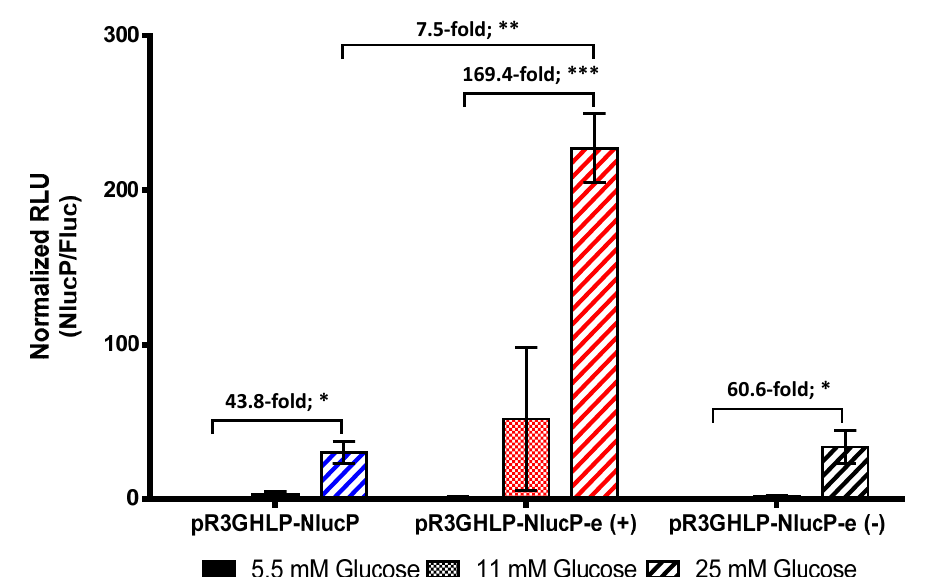
Figure 5. Incorporation of human albumin 3 (cid:48) untranslated region with intron, 3 (cid:48) albumin enhancer (3 (cid:48) iALB) for improved glucose responsiveness and enhanced gene expression level. Glucose responsive gene expression conferred by pR3GHLP-NlucP-e (3 (cid:48) iALB denoted as “e” in plasmid’s name) at various glucose concentration at 5.5, 11, and 25 mM. The expression level of R3GHLP promoter with 3 (cid:48) iALB at forward direction, pR3GHLP-NlucP-e( + ) and reverse direction, pR3GHLP-NlucP-e( − ) were